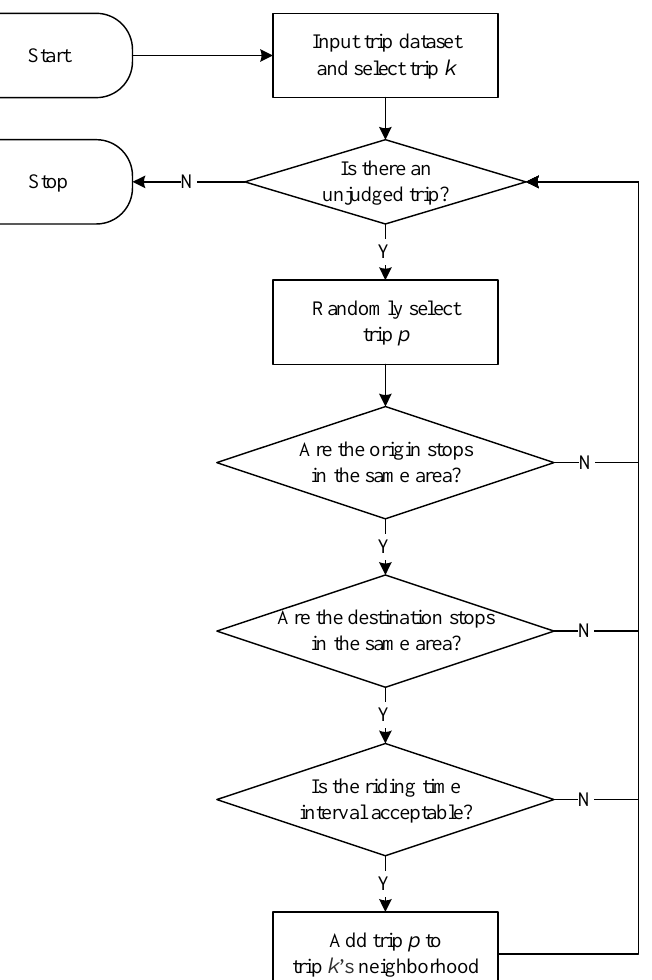
Figure 2. Process for retrieving the neighborhood of trip k .